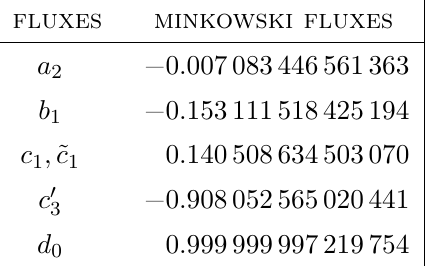
Table 3 . Choice of (cid:13)uxes that generates a non-supersymmetric Minkowski critical point. All of the above (cid:13)ux parameters are metric (cid:13)ux components, while the gauge (cid:13)uxes are